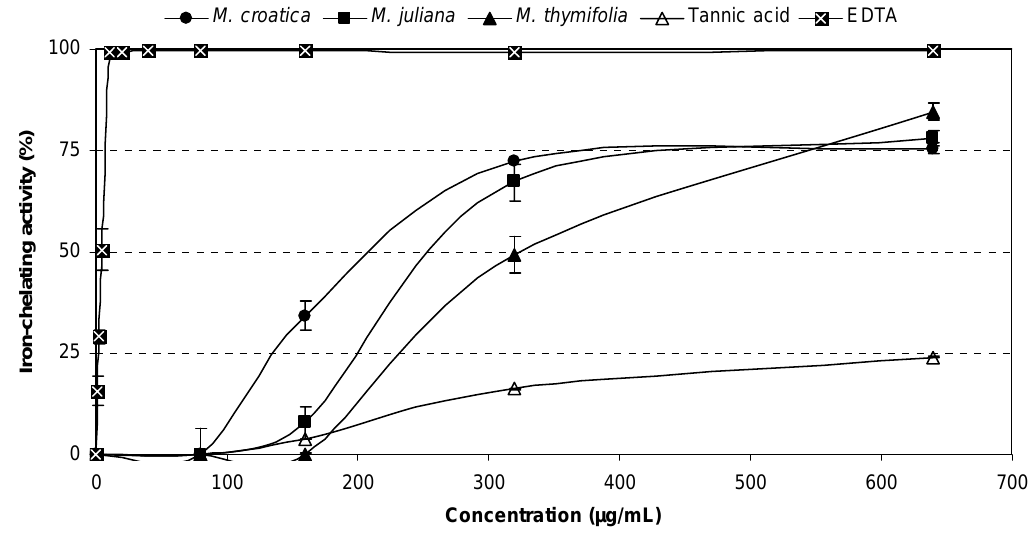
Figure 5. Iron(II) ions chelating activities of Micromeria ethanolic extracts in comparison with tannic acid and a reference chelator.